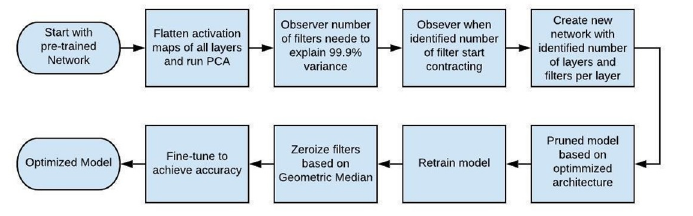
Fig 2. Flowchart of the proposed PCA driven mixed pruning